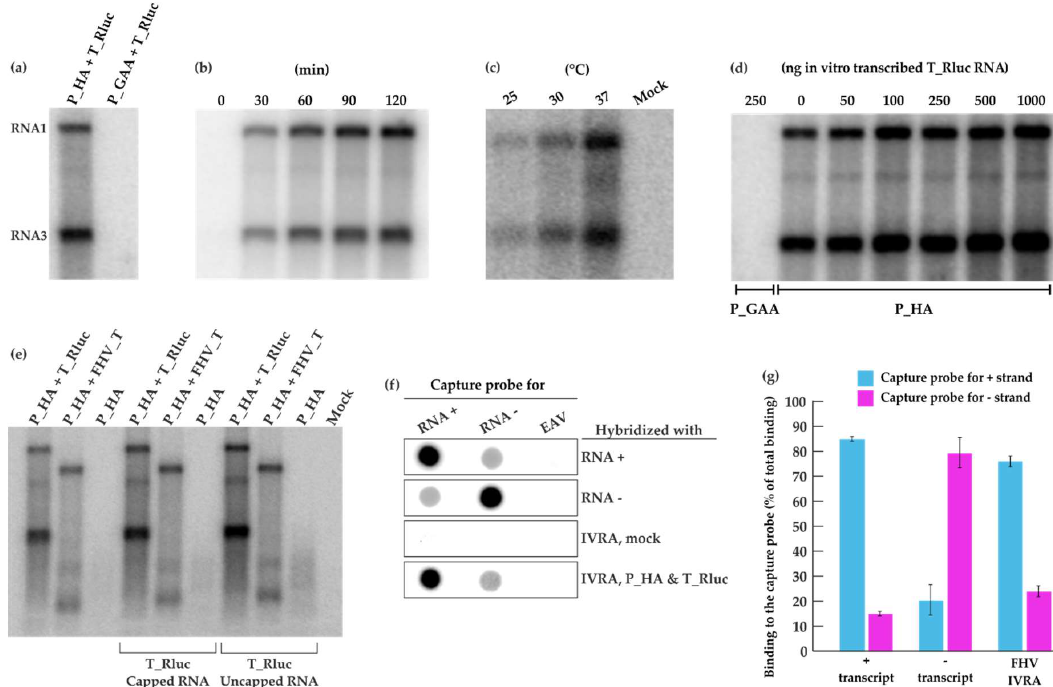
Figure 3. FHV RNA replication in vitro. ( a ) BSR T7/5 cells were transfected with P_HA + T_Rluc and P_GAA + T_Rluc. A crude mitochondrial pellet (CMP) was isolated by differential centrifugation 40 h